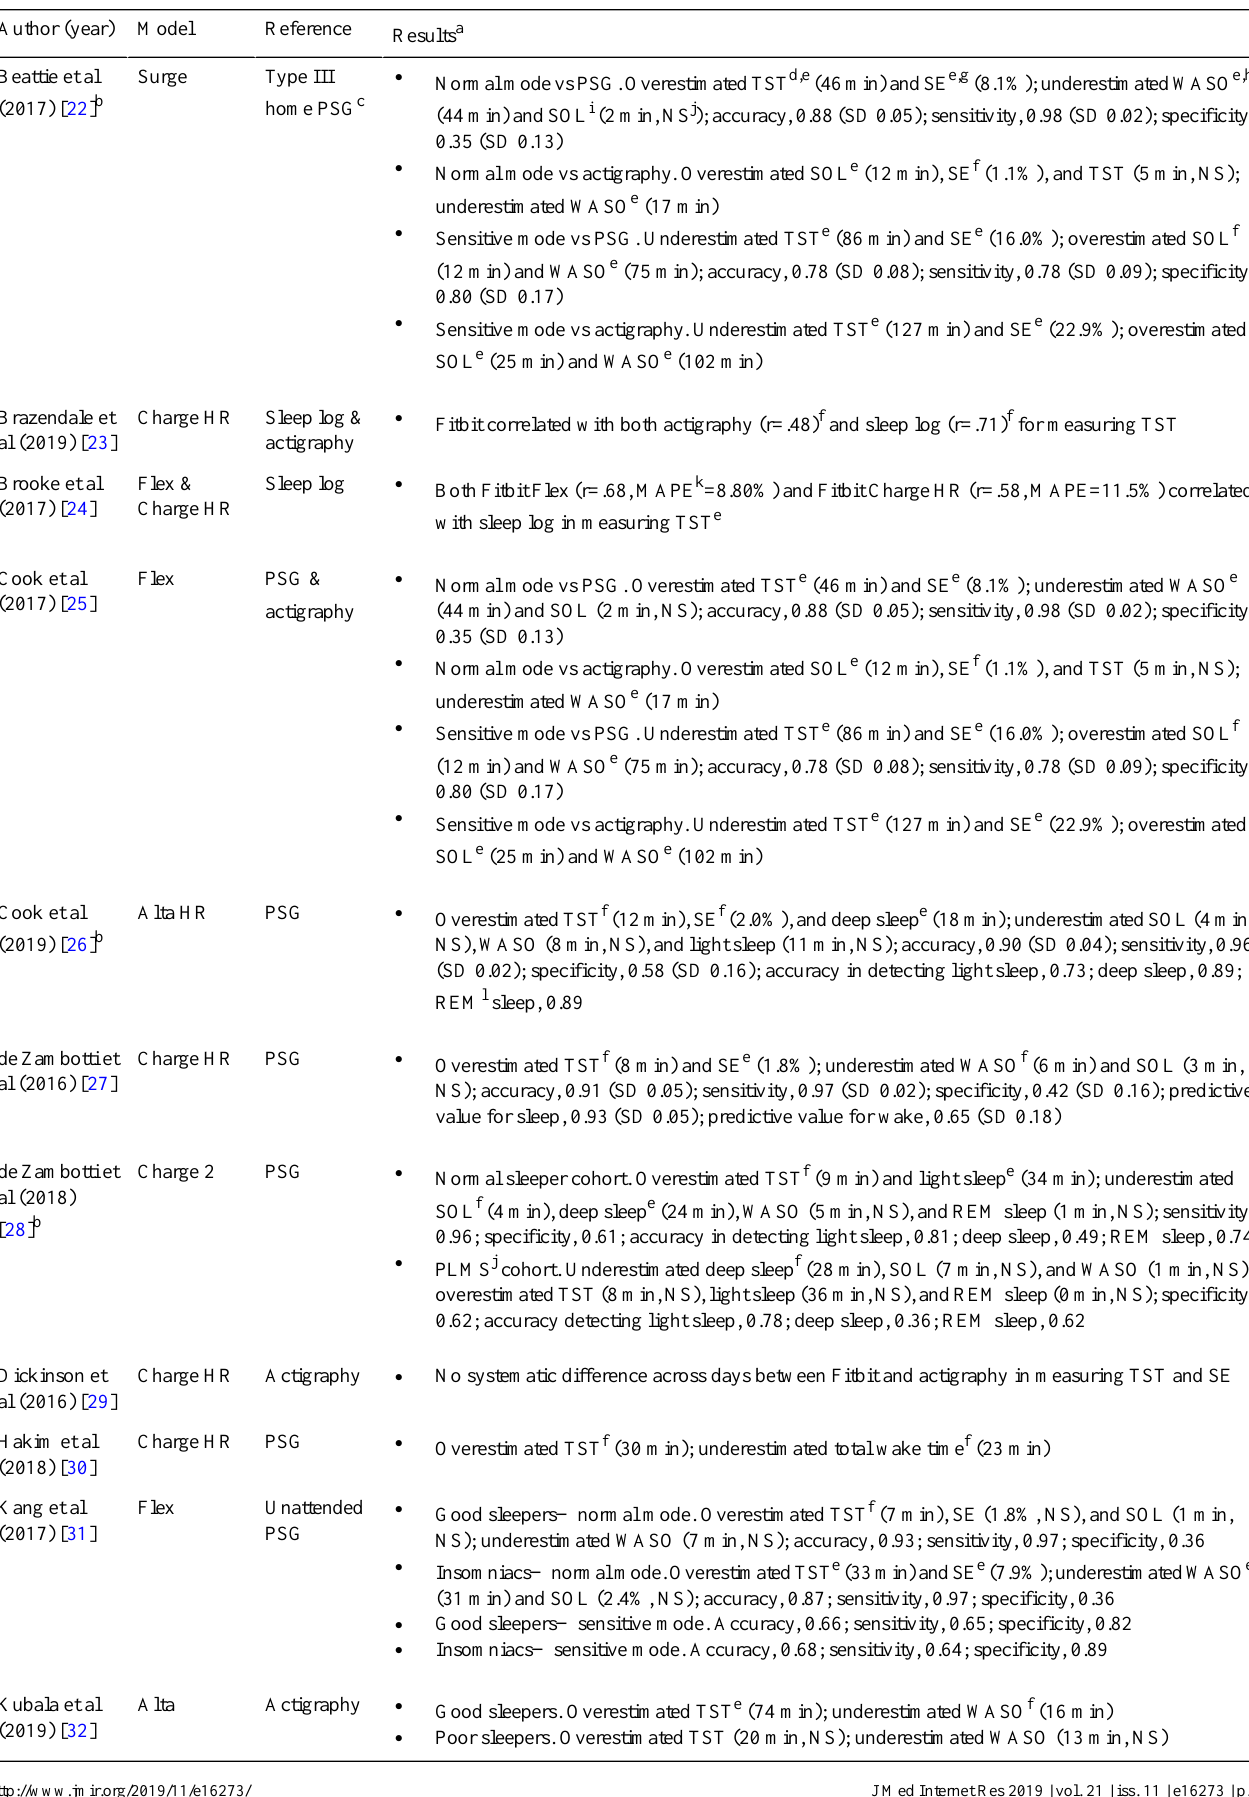
Table 2. Results from qualifying publications involving both early-generation, nonsleep-staging and newer-generation, sleep-staging Fitbit models. Results a ReferenceModelAuthor